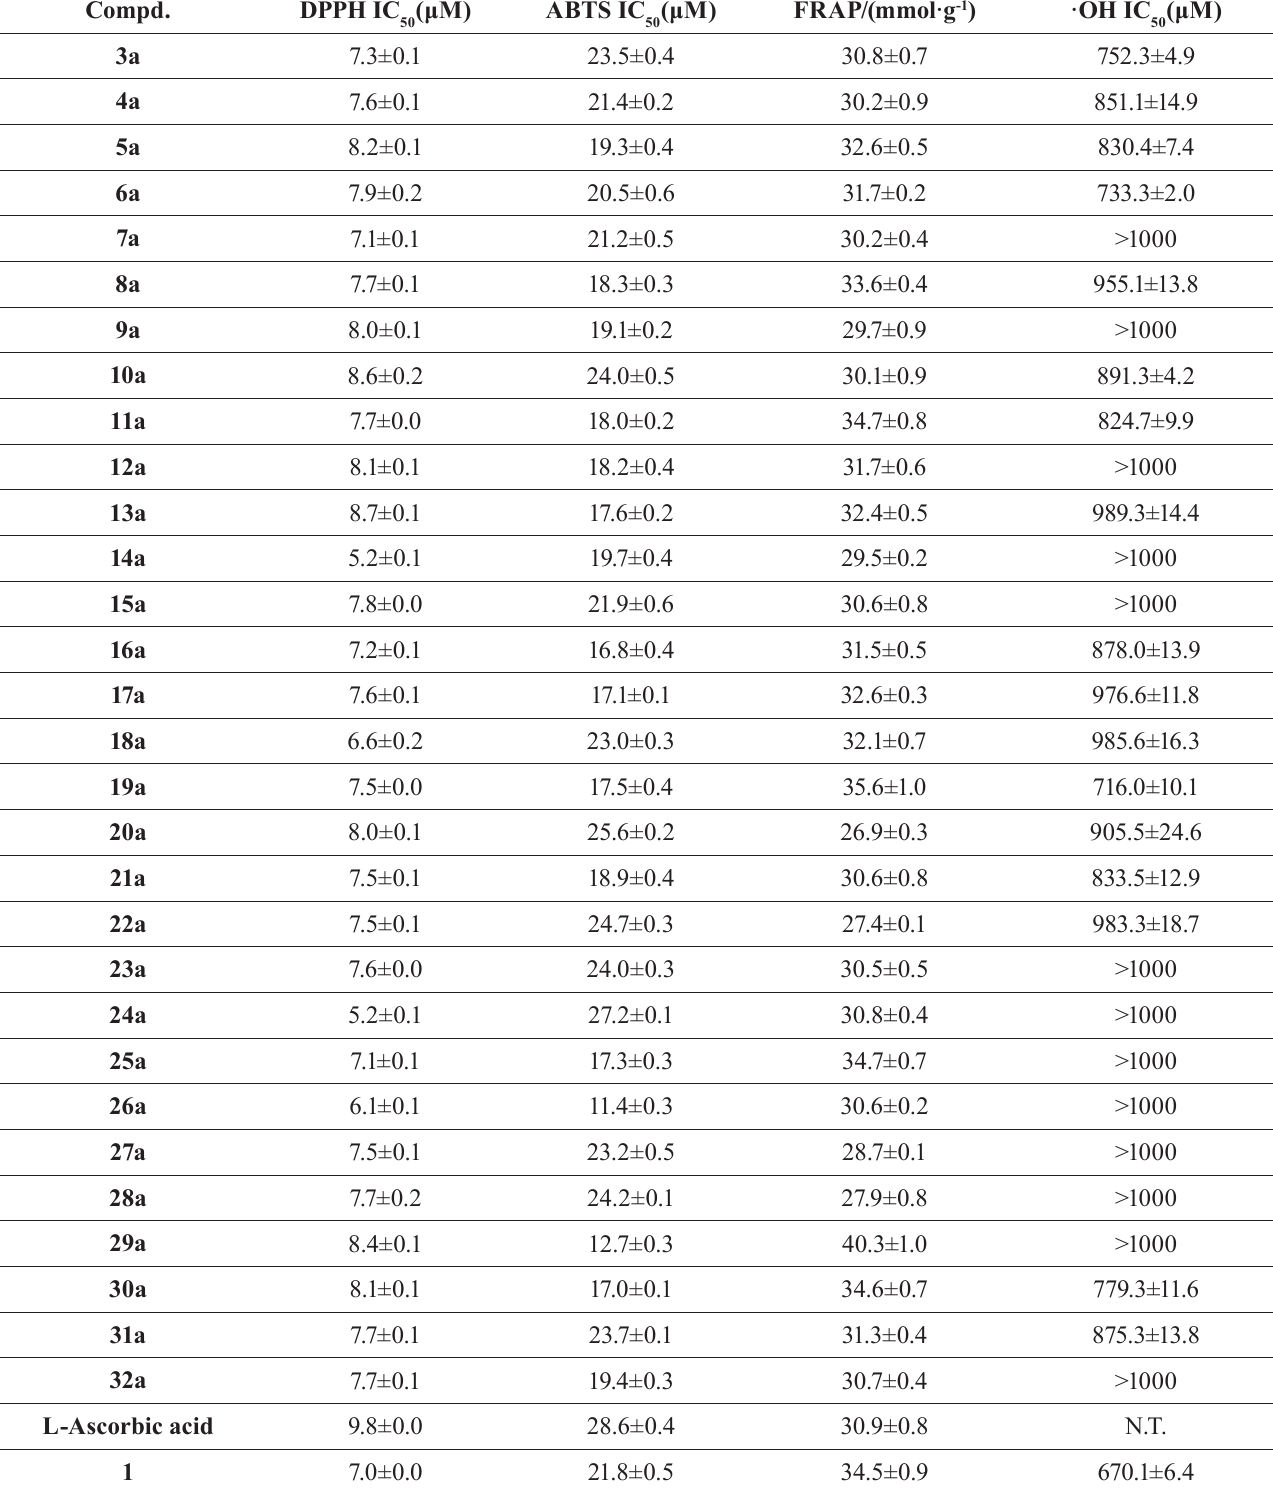
TABLE I - A ntioxidant activity of compounds 3a–32a